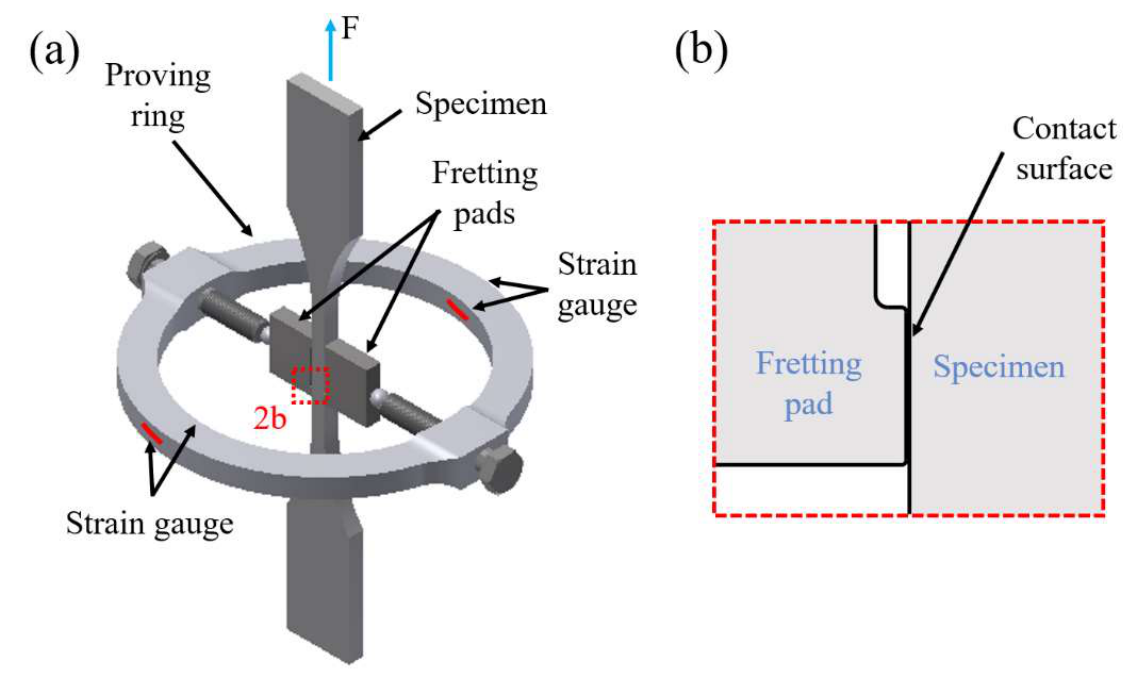
Figure 2. Schematic diagram of ( a ) the fretting fatigue experimental setup and ( b ) the contact surface between the fretting pad and specimen.